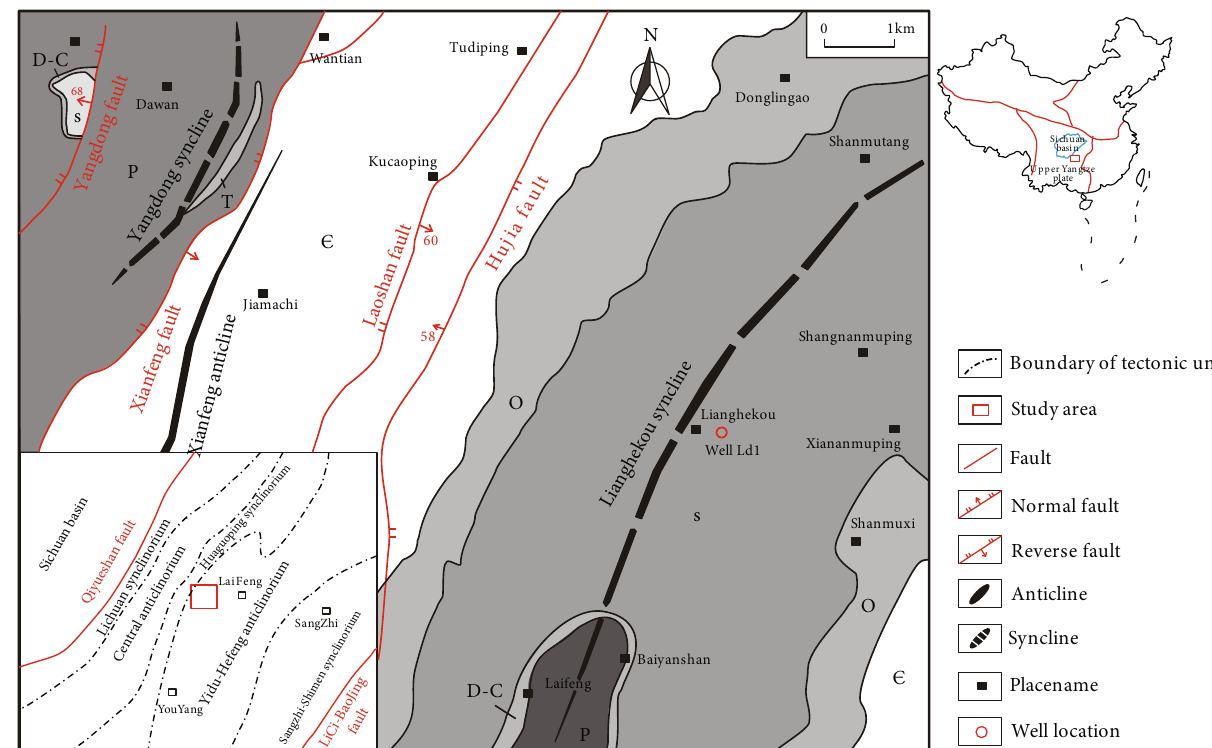
Figure 1: Geological background and location of well Ld1 in the study